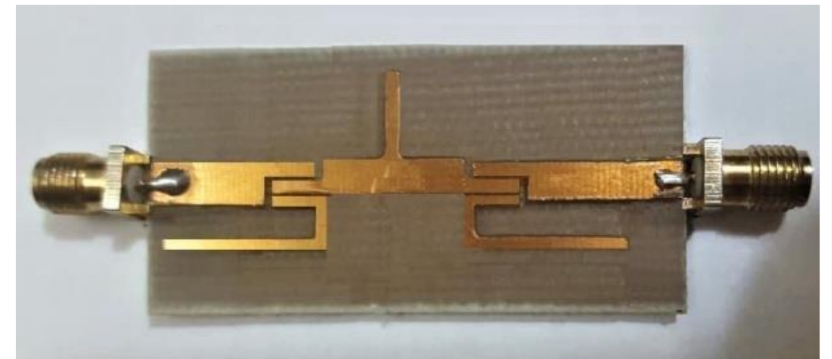
Figure 10. The prototype of the proposed microwave filter.